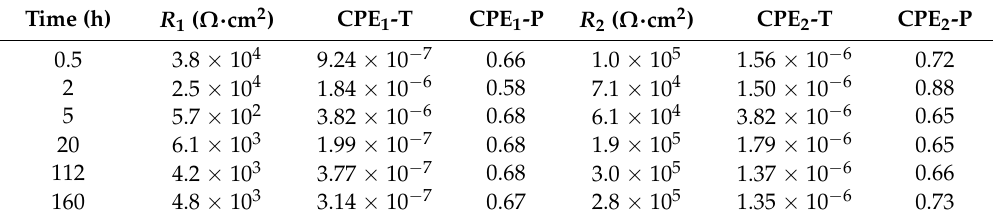
Figure 7. Bode plots of MgO coating ( a , b ) and ZrO 2 coating ( c , d ) at different immersion times in SBF. Table 3. Fitting results of the EIS plots of the MgO coating on AZ31 magnesium